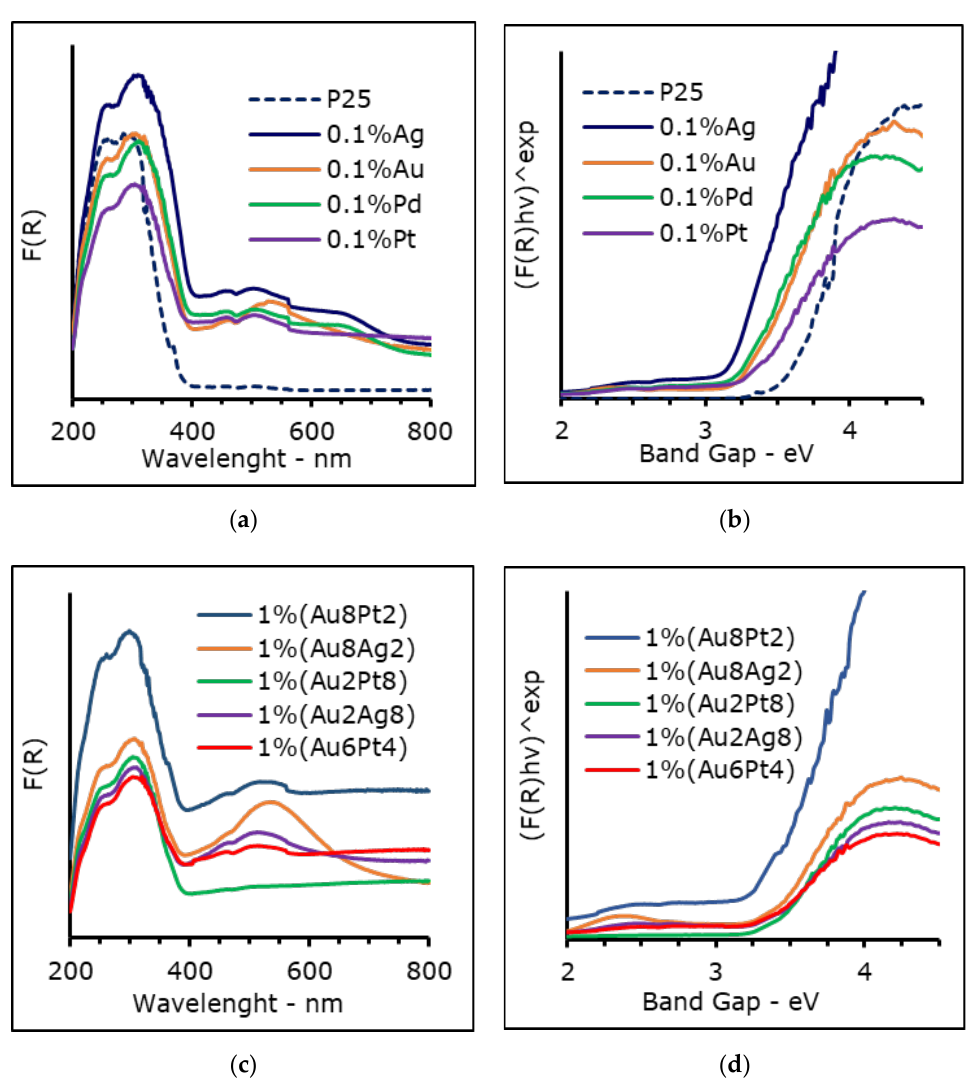
Figure 1. DRS UV-Vis spectra of ( a ) mono-metallic and ( c ) bi-metallic photo-catalysts and respective Kubelka-Munk transformation (r = 1/2) plotted against the BG energy ( b , d ). The step at 565 nm is due to instrumental reasons. Table 1. Band gap values (direct and indirect) of selected photo-catalyst obtained by reflectance measurements and Kubelka-Munk transformation.